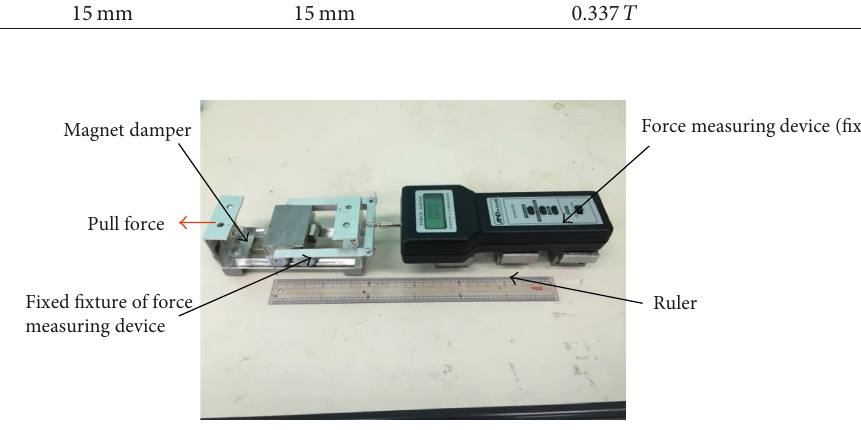
Figure 4: Force measurement setup.